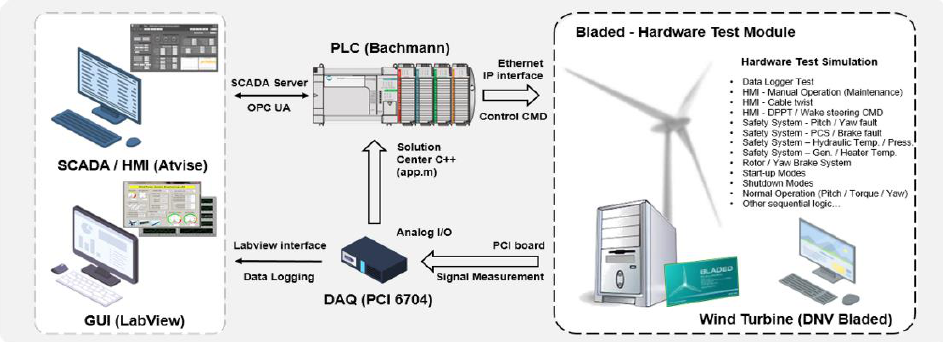
Figure 5. Flowchart of hardware in the loop simulator.